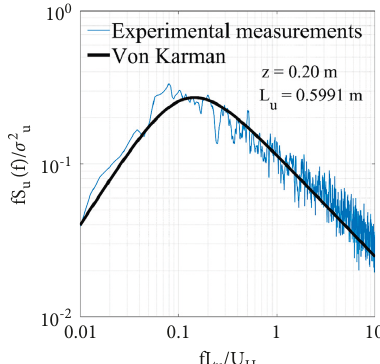
Figure 7: Comparison of experimental PSDF and von karman